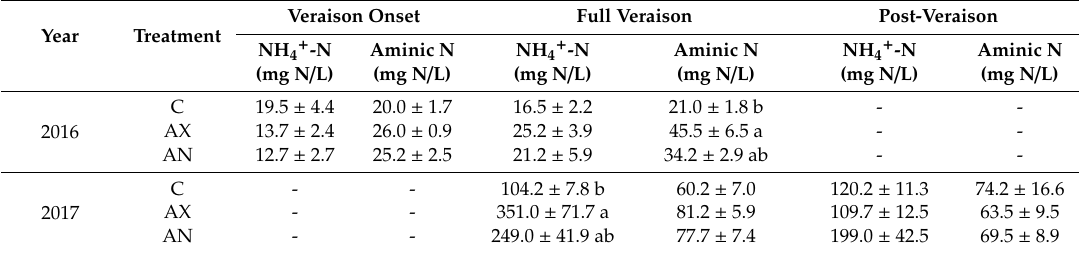
Table 2. Ammonium nitrogen (NH 4 + N) and aminic nitrogen (mean ± standard error of the mean) measured at harvest in 2016 and 2017 in control untreated plants (C) and in vines sprayed at veraison onset, full veraison or post-veraison with Aminoprotein (AN) or Aminomax (AX). Within columns and separated by year, means (n = 8) followed by di ff erent letters are significantly di ff erent according to Duncan’s test ( p ≤